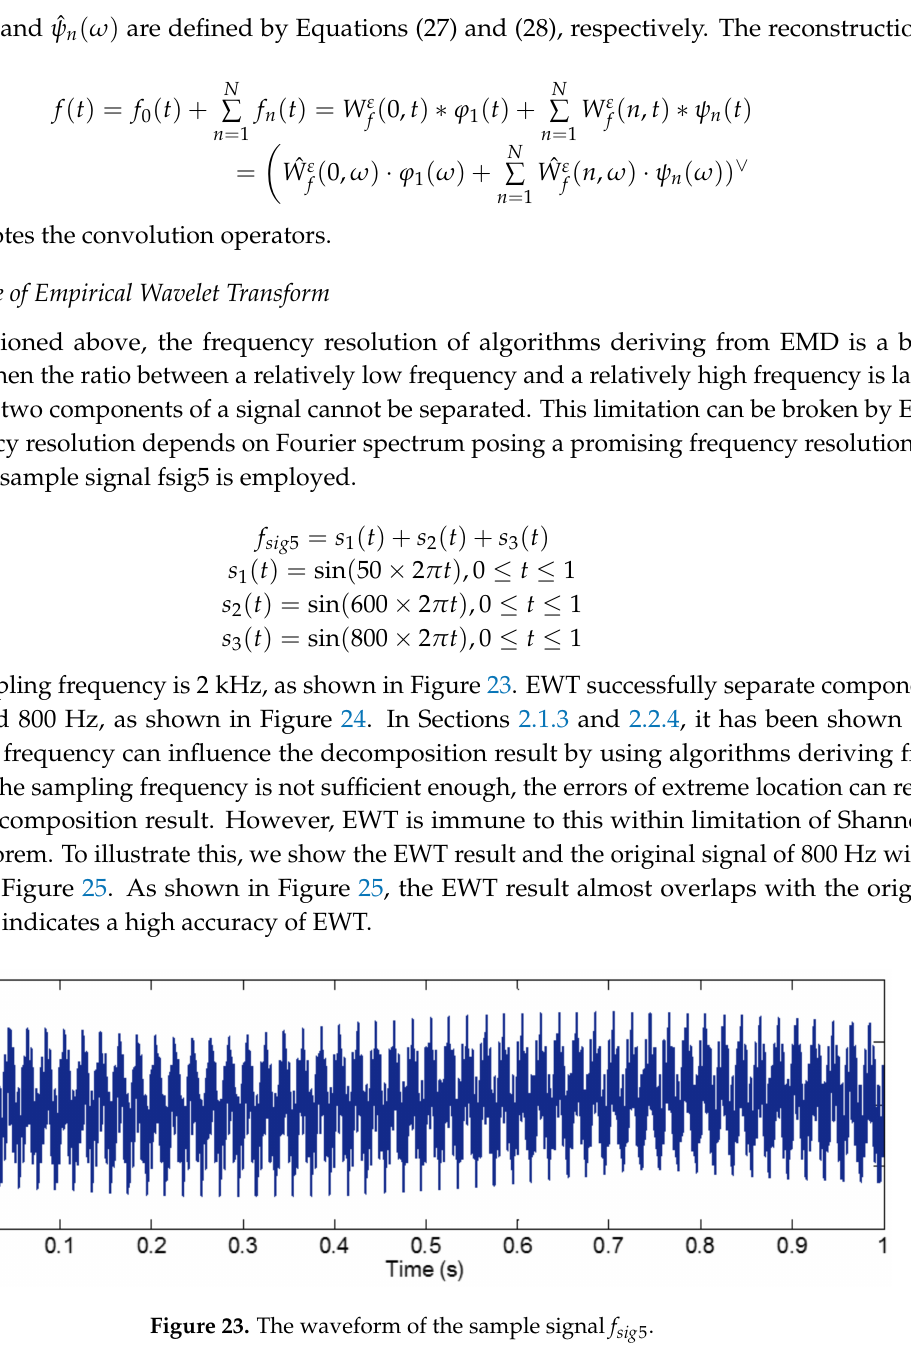
Figure 23. The waveform of the sample signal f sig 5